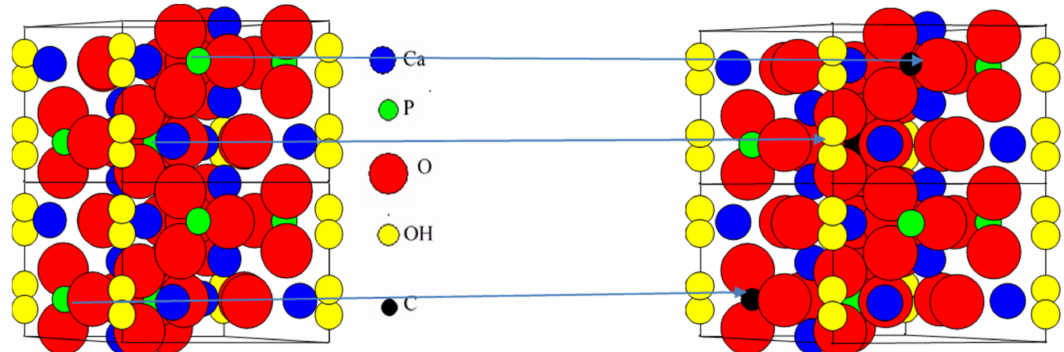
Figure 1. Partial replacement of (PO 4 ) 3 − anions with (CO 3 ) 2 − in hydroxyapatite.